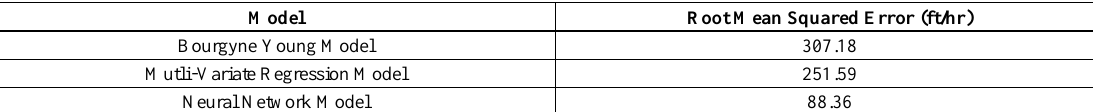
Table 4. Model performance comparison